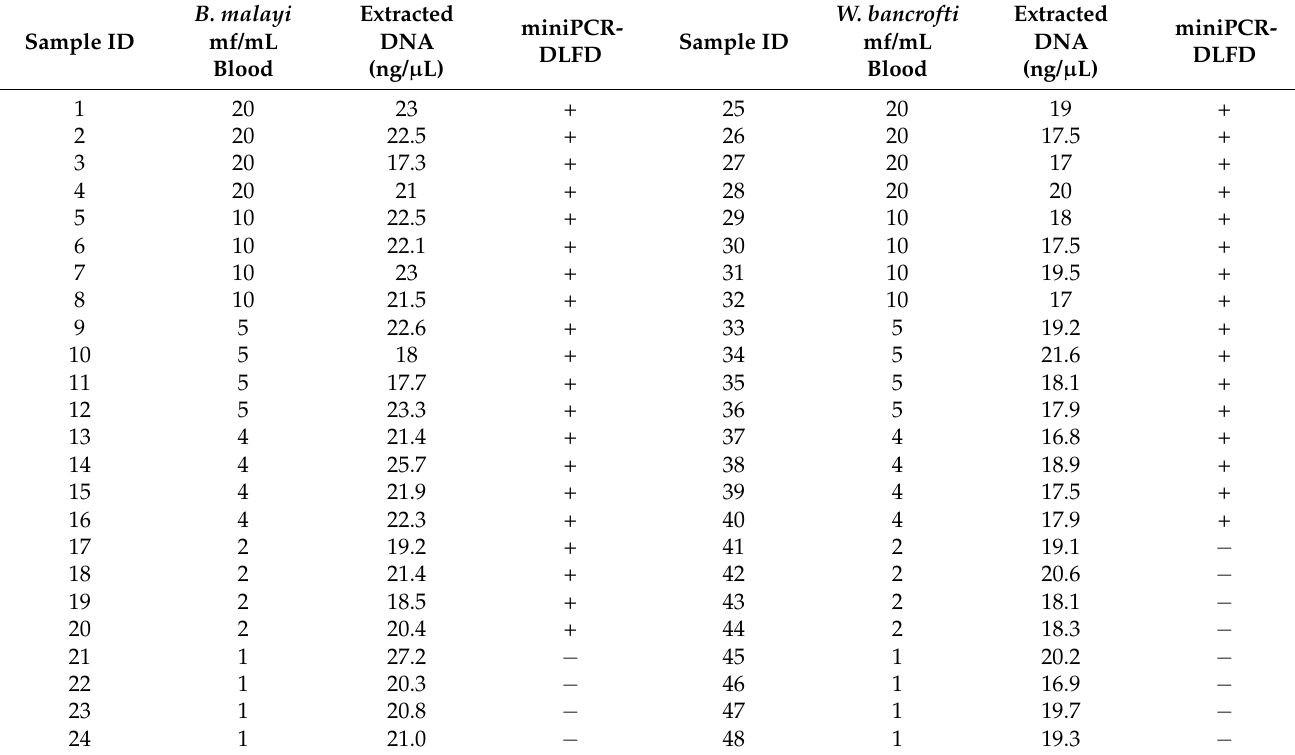
Table 1. The sample ID, number of spiked mf of B. malayi and W. bancrofti in 1 milliliter (mL) blood sample, concentration of extracted DNA (ng/ µ L), and results of the miniPCR-DLFD assay.